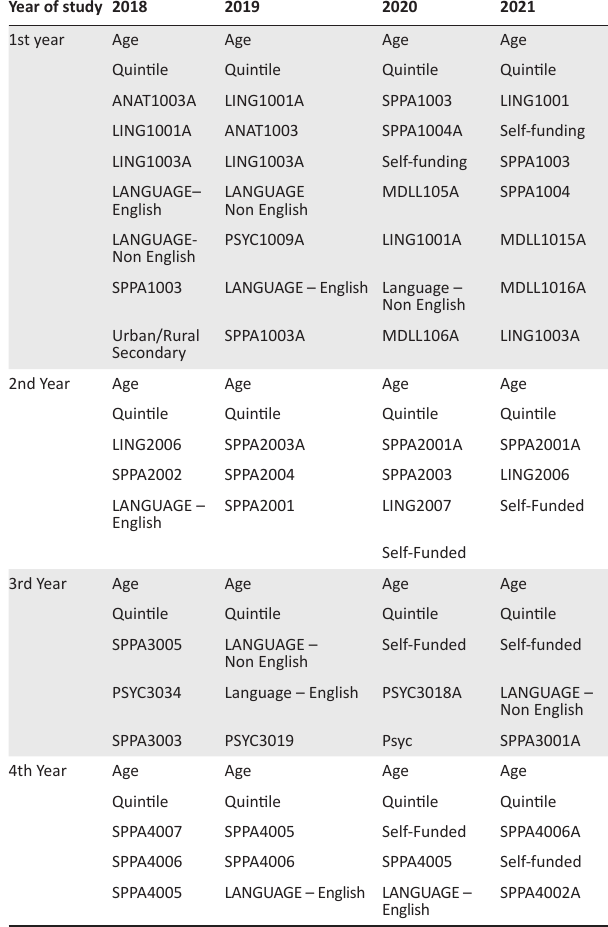
TABLE 3: Attributes in order of importance.